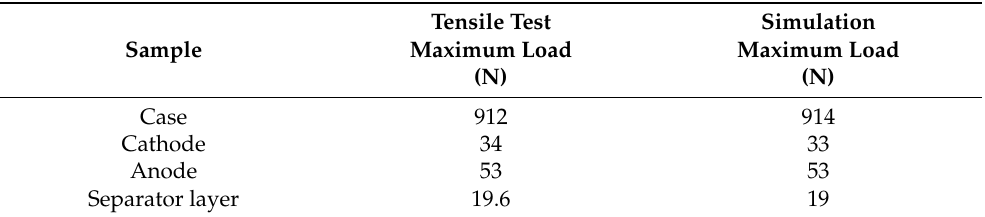
Table 3. Comparison of the numerical and experimental tensile test results.